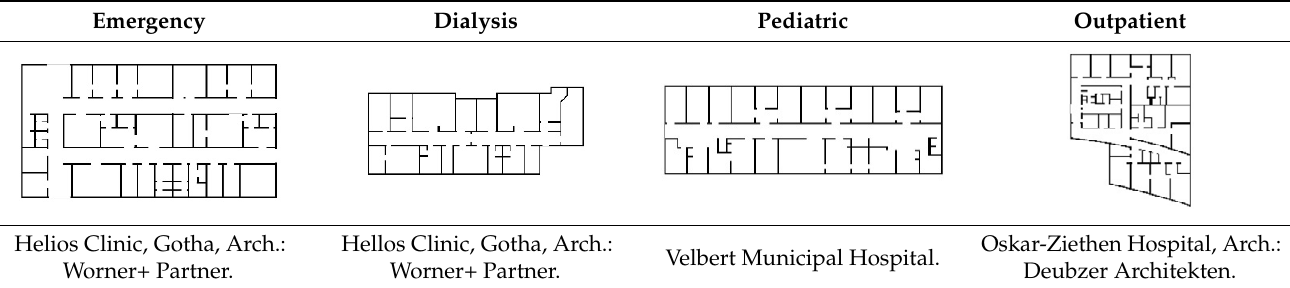
Table 9. Dimensional requirements of the wards compared to standards.